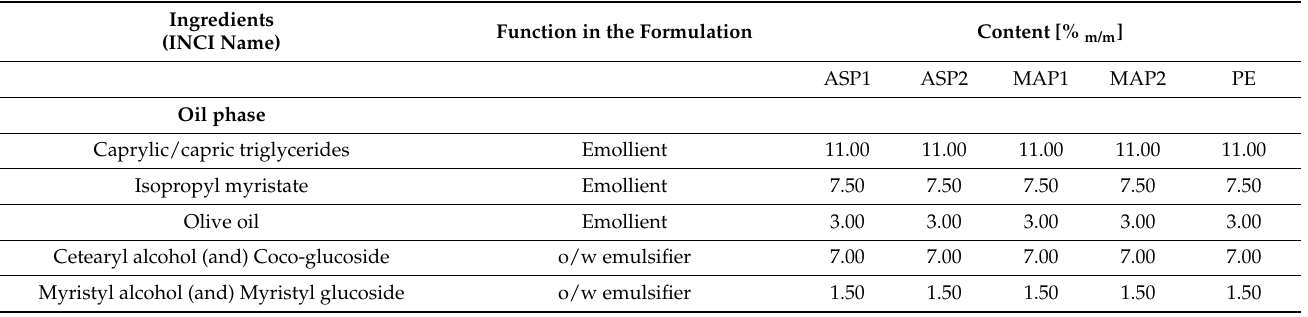
Table 1. Qualitative and quantitative compositions (%, ( w / w )) of emulgel